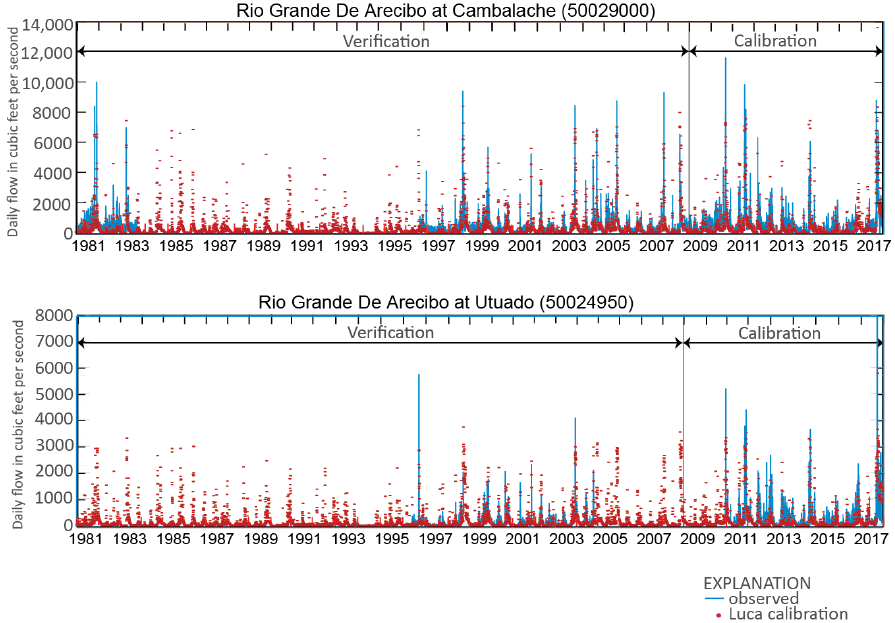
Figure 14. Modeled daily streamflows at observation stations, with Luca calibration. Horizontal bars indicate years used for validation and calibration.